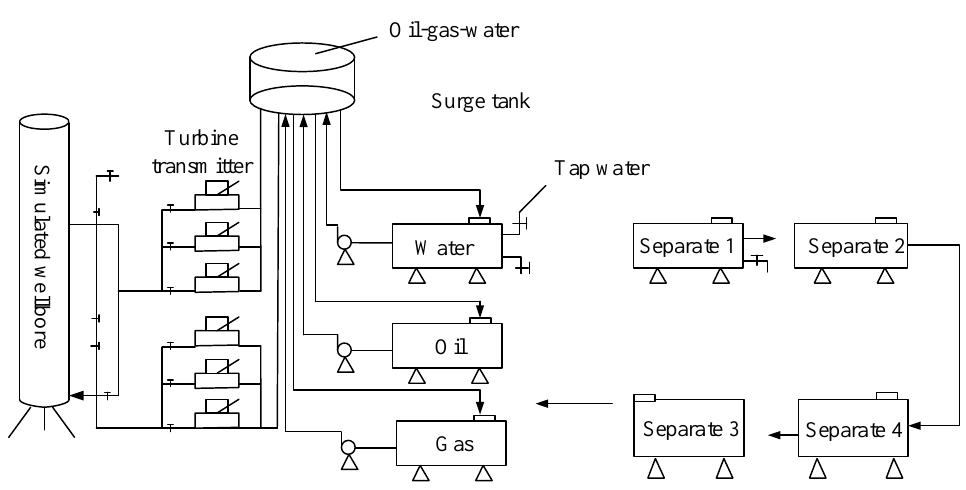
Figure 12. Schematic diagram of multiphase flow experimental device.